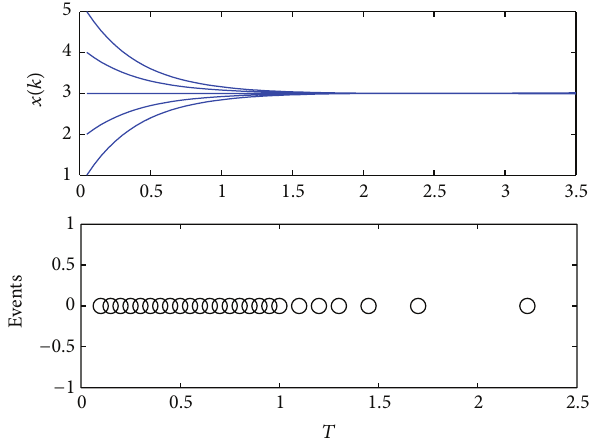
Figure 3: Protocol (6) for 𝑝 = 0.9 .